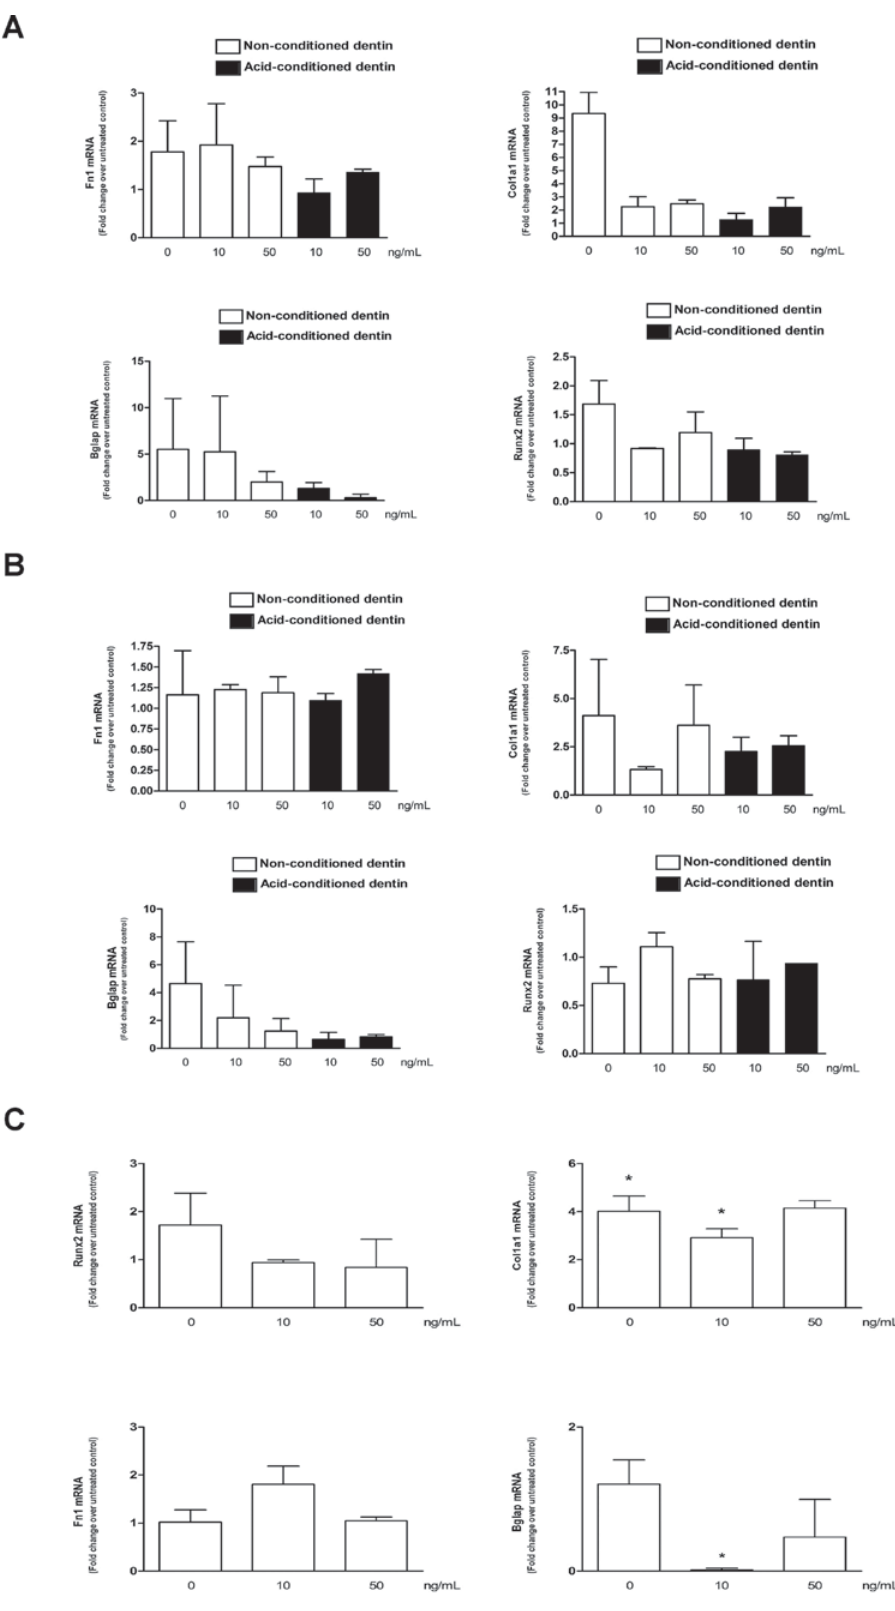
Sci.Figure 3- (cid:3) (cid:53)(cid:72)(cid:79)(cid:68)(cid:87)(cid:76)(cid:89)(cid:72)(cid:3) (cid:70)(cid:75)(cid:68)(cid:81)(cid:74)(cid:72)(cid:86)(cid:3) (cid:76)(cid:81)(cid:3) (cid:74)(cid:72)(cid:81)(cid:72)(cid:3) (cid:72)(cid:91)(cid:83)(cid:85)(cid:72)(cid:86)(cid:86)(cid:76)(cid:82)(cid:81)(cid:3) (cid:11)(cid:80)(cid:53)(cid:49)(cid:36)(cid:12)(cid:3) (cid:82)(cid:73)(cid:3) (cid:53)(cid:88)(cid:81)(cid:91)(cid:21)(cid:15)(cid:3) (cid:38)(cid:82)(cid:79)(cid:20)(cid:68)(cid:20)(cid:15)(cid:3) (cid:41)(cid:81)(cid:3) (cid:68)(cid:81)(cid:71)(cid:3) (cid:37)(cid:74)(cid:79)(cid:68)(cid:83)(cid:3) (cid:69)(cid:92)(cid:3) (cid:70)(cid:72)(cid:80)(cid:72)(cid:81)(cid:87)(cid:82)(cid:69)(cid:79)(cid:68)(cid:86)(cid:87)(cid:86)(cid:3) (cid:11)(cid:50)(cid:38)(cid:38)(cid:48)(cid:15)(cid:3) (cid:83)(cid:68)(cid:81)(cid:72)(cid:79)(cid:3) (cid:179)(cid:36)(cid:180)(cid:12)(cid:15)(cid:3) (cid:83)(cid:72)(cid:85)(cid:76)(cid:82)(cid:71)(cid:82)(cid:81)(cid:87)(cid:68)(cid:79)(cid:3)(cid:79)(cid:76)(cid:74)(cid:68)(cid:80)(cid:72)(cid:81)(cid:87)(cid:3)(cid:191)(cid:69)(cid:85)(cid:82)(cid:69)(cid:79)(cid:68)(cid:86)(cid:87)(cid:86)(cid:3)(cid:11)(cid:80)(cid:51)(cid:39)(cid:47)(cid:15)(cid:3)(cid:83)(cid:68)(cid:81)(cid:72)(cid:79)(cid:3)(cid:179)(cid:37)(cid:180)(cid:12)(cid:3)(cid:68)(cid:81)(cid:71)(cid:3)(cid:69)(cid:82)(cid:81)(cid:72)(cid:3)(cid:80)(cid:68)(cid:85)(cid:85)(cid:82)(cid:90)(cid:3)(cid:86)(cid:87)(cid:85)(cid:82)(cid:80)(cid:68)(cid:79)(cid:3)(cid:70)(cid:72)(cid:79)(cid:79)(cid:86)(cid:3)(cid:11)(cid:37)(cid:48)(cid:54)(cid:38)(cid:15)(cid:3)(cid:83)(cid:68)(cid:81)(cid:72)(cid:79)(cid:3)(cid:5)(cid:38)(cid:180)(cid:12)(cid:3)(cid:70)(cid:88)(cid:79)(cid:87)(cid:88)(cid:85)(cid:72)(cid:71)(cid:3)(cid:82)(cid:81)(cid:3)(cid:71)(cid:76)(cid:73)(cid:73)(cid:72)(cid:85)(cid:72)(cid:81)(cid:87)(cid:3)(cid:86)(cid:88)(cid:69)(cid:86)(cid:87)(cid:85)(cid:68)(cid:87)(cid:72)(cid:86)(cid:29)(cid:3) tissue culture-treated plastic, non-conditioned (NC) and conditioned (C) dentin slices. The same quantity of cells (5x104) was seeded onto the different substrates and total RNA collected after 24 hours. Gene expression of the indicated target genes was determined by RT-qPCR. Bars indicate the mean result of the relative change (fold regulation) of normalized target gene expression in comparison with vehicle-treated samples in each substrate. Bars indicate mean and vertical lines indicate standard deviation of a minimum of three independent experiments 695 J Appl Oral